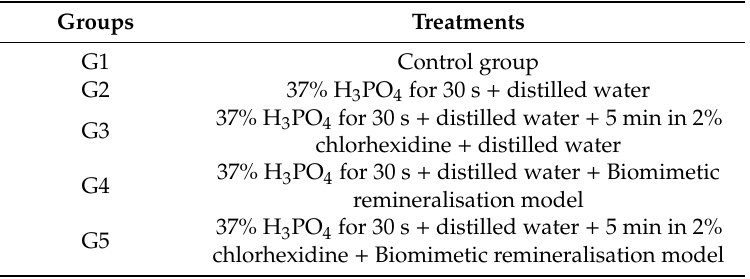
Table 1. Distribution of experimental